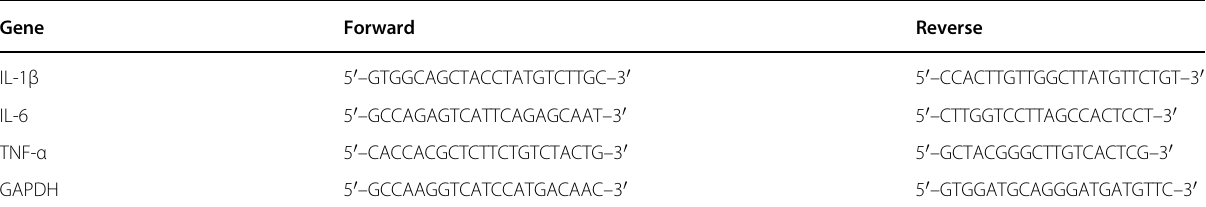
Table 1 Primers of targeted